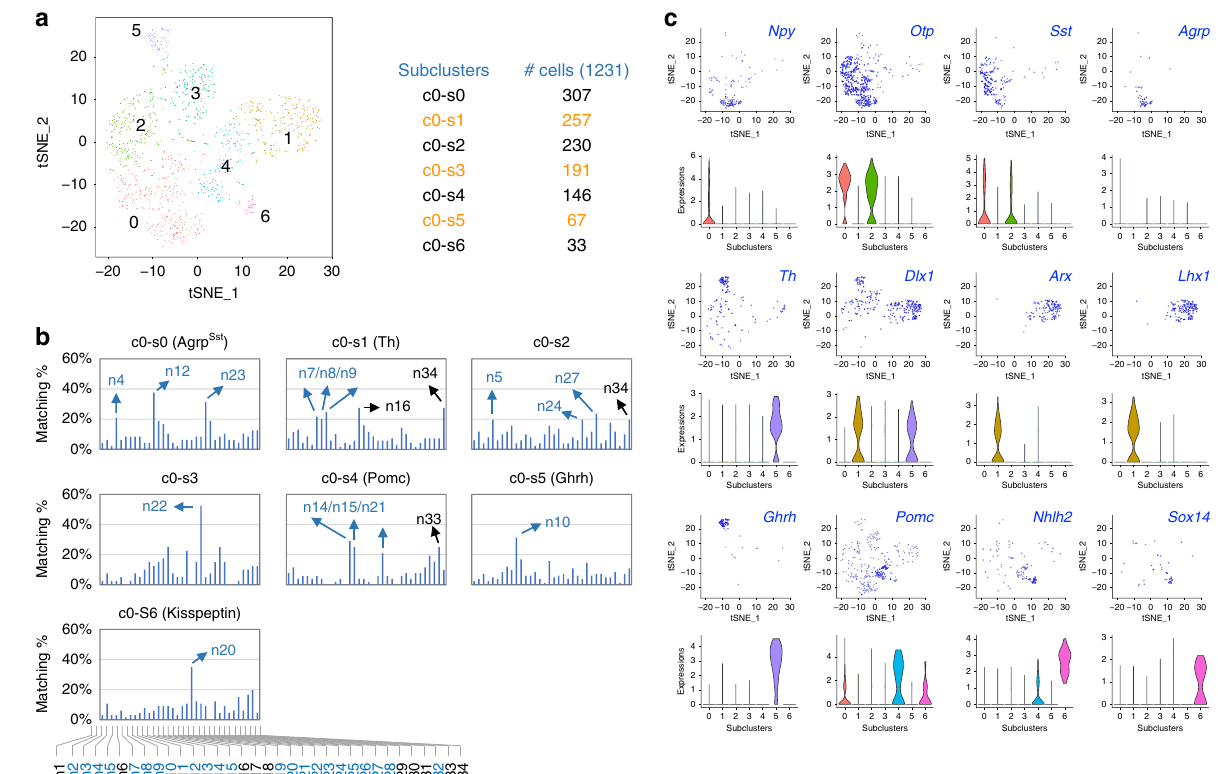
Fig. 2 Reclustering of the cluster c0. a Spectral tSNE plot of 1,231 cells from the cluster c0, colored according to gene expression, reveal 7 subclusters of cells (the subclusters c0-s0 to c0-s6). The number of cells (#) in each subcluster is as shown. b Similarity of the E15 subclusters c0-s0 to c0-s6 to the adult neurons n1 to n34, which include 24 ARC neurons highlighted in blue, was determined by calculating what % of genes speci fi cally enriched in each subcluster belong to the top 200 genes enriched in each of the adult neurons n1 to n34. All seven subclusters showed signi fi cant similarity to at least one type of the adult neurons. c Spectral tSNE plot of 1,231 cells in the cluster c0, colored for the expression of representative key markers of ARC neurons, Npy/Otp/Sst/Agrp for Agrp Sst -neurons, Th/Dlx1/Arx/Lhx1 for Th-neurons, Th/Dlx1/Ghrh for Ghrh-neurons, Pomc/Nhlh2 for Pomc-neurons, and Nhlh2/ Sox14 for Kisspeptin-neurons. Violin plots for each gene are also